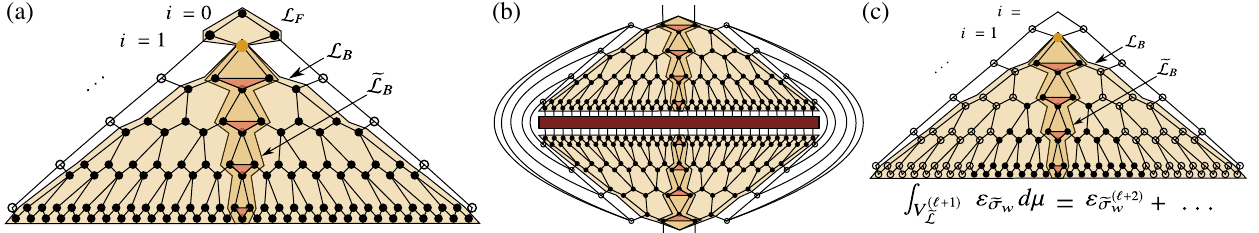
˜ L (shaded in yellow) and the effective light cone (shaded in a B B , we define an B . w which are not in L simplify to identity when L B − 1 Þ leads to a summation of ˜ L B . As schematically shown, in the computation of ε there ˜ σ ð l þ 2 Þ ˜ σ ð l þ 2 Þ w w